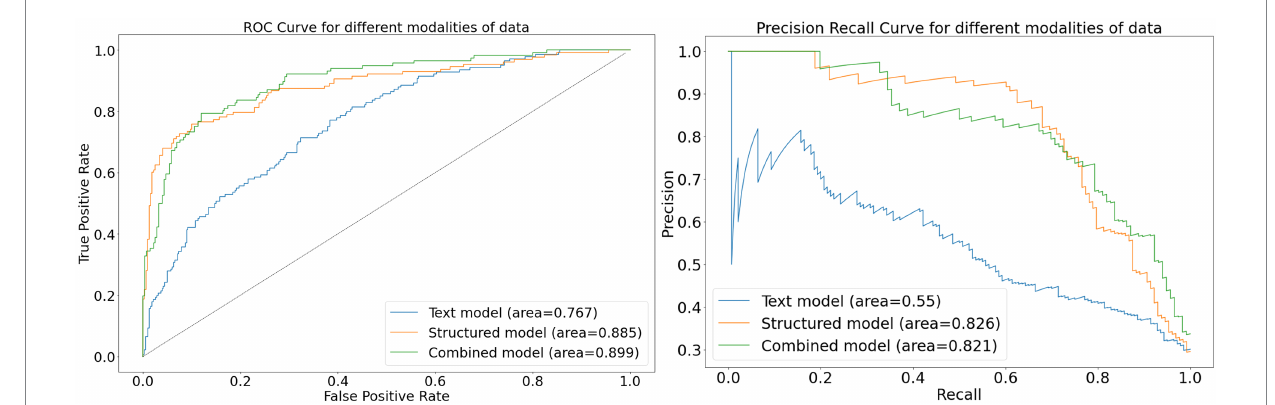
FIGURE 5 Receiver-operating and precision-recall curves for models. This figure depicts receiver operating characteristic curves and precision recall curves for models predicting glaucoma progression to surgery. The free-text model uses only clinical notes as inputs into a convolutional neural network; the structured model uses only structured electronic health records data as inputs into a deep learning model; and the combined model fuses both structured and text inputs into a fusion deep learning